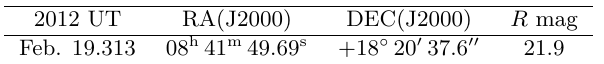
Table 1. Discovery time and position of the asteroid 2012